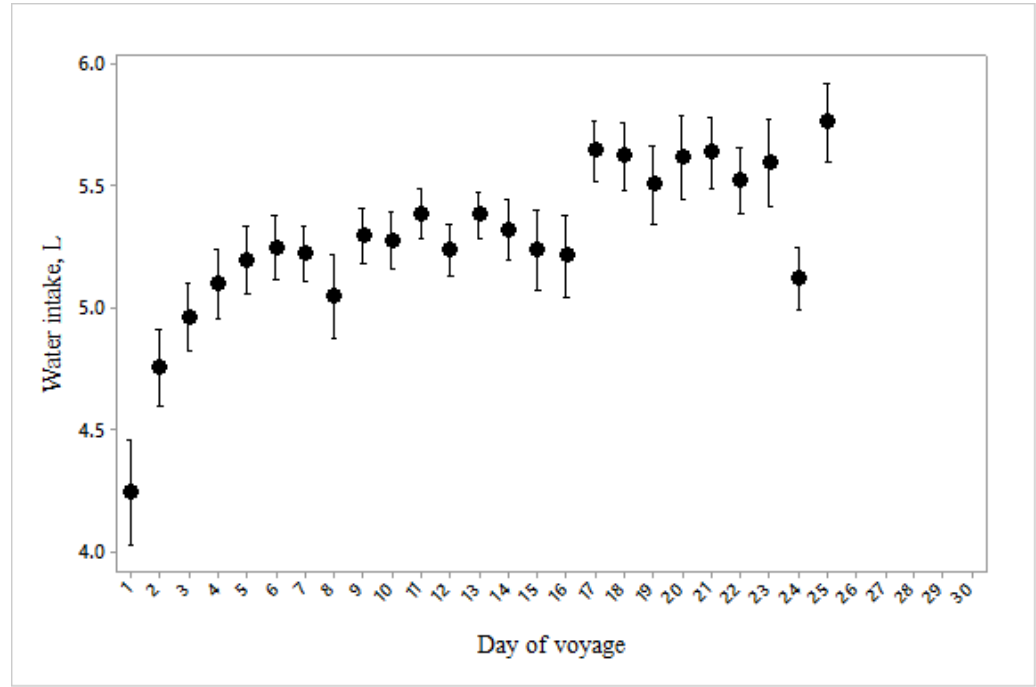
Figure 14. Water consumption per sheep during the 25 days of the voyage ( n = 3581).